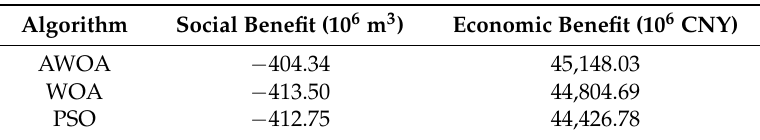
Table 13. Results for objective function values of AWOA, WOA, and PSO.